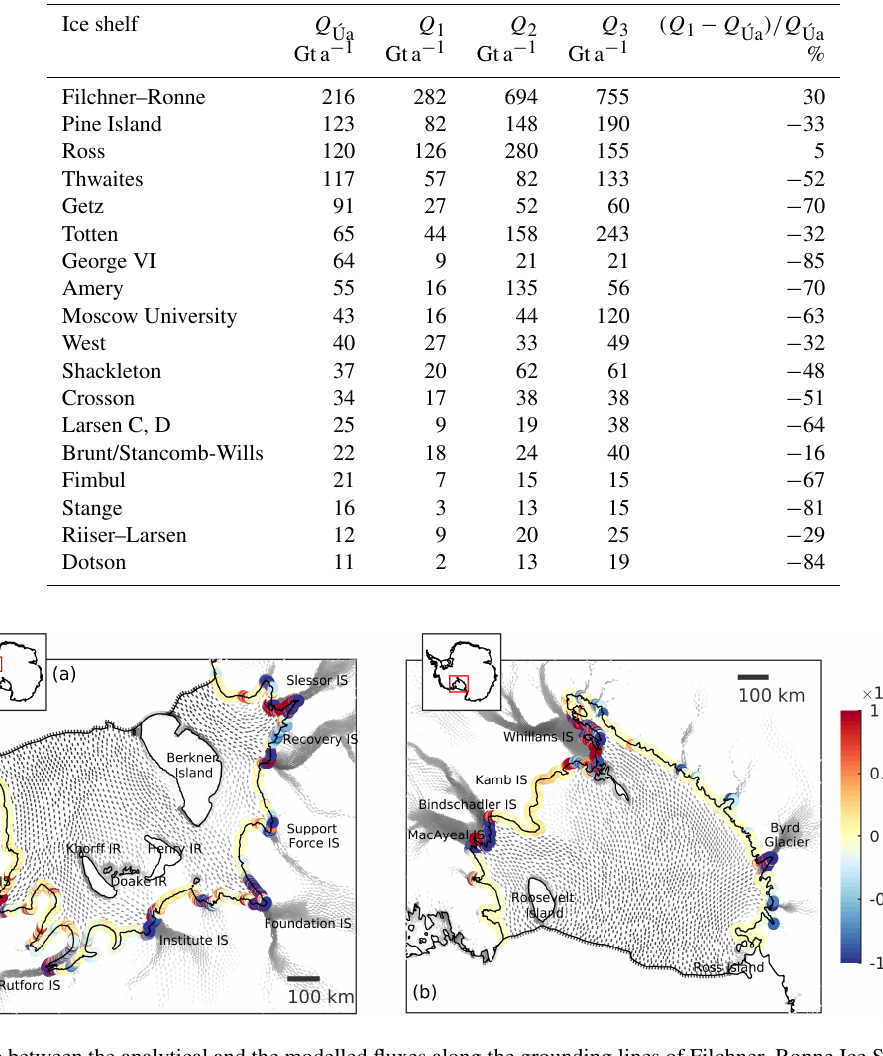
Figure 5. Difference between the analytical and the modelled fluxes along the grounding lines of Filchner–Ronne Ice Shelf (a) and Ross Ice Shelf (b) . Analytical fluxes are calculated based on θ 1 defined in Eq. (11). In locations where the formula yields unphysical results, fluxes are set to zero. Grey arrows show the modelled ice flow. IS denotes ice streams; IR denotes ice rises or rumples. Grounding line and ice front locations are indicated in